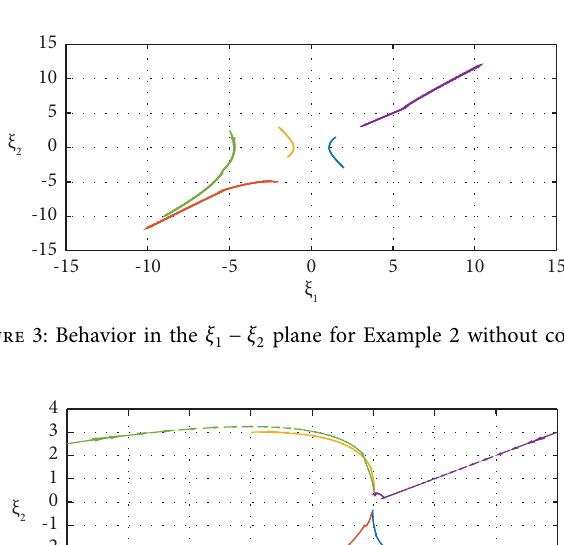
Figure 4: Behavior in the ξ